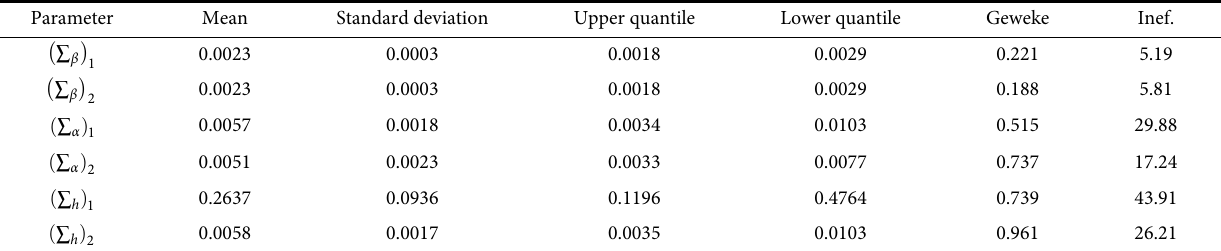
Table 3 Estimation results of TVP-VAR